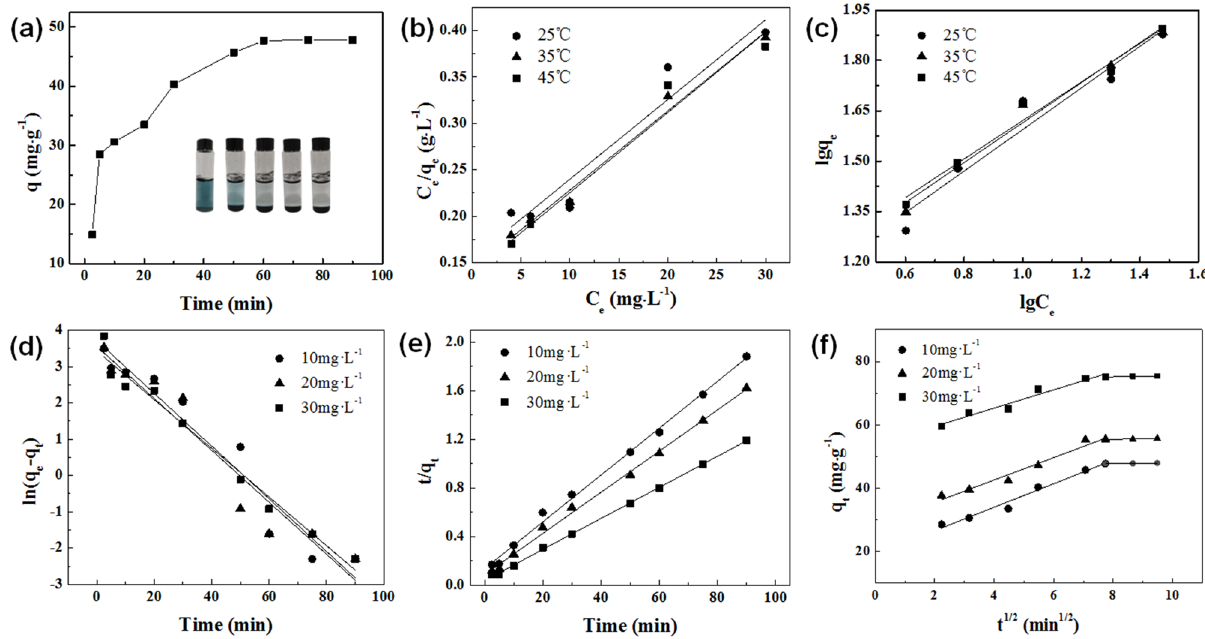
Figure 7. ( a ) Adsorption isotherms of MB on HPC, the inset shows digital photos of the absorption of MB by HPC in water, ( b ) Adsorption kinetics of MB on HPC treated by Langmuir isotherm, ( c ) Adsorption kinetics of MB on HPC treated by Freundlich isotherm, ( d ) Fitting results of pseudo-first-order kinetic model, ( e ) Fitting results of quasi-secondary kinetic model, ( f ) Fitting results of intraparticle diffusion model.